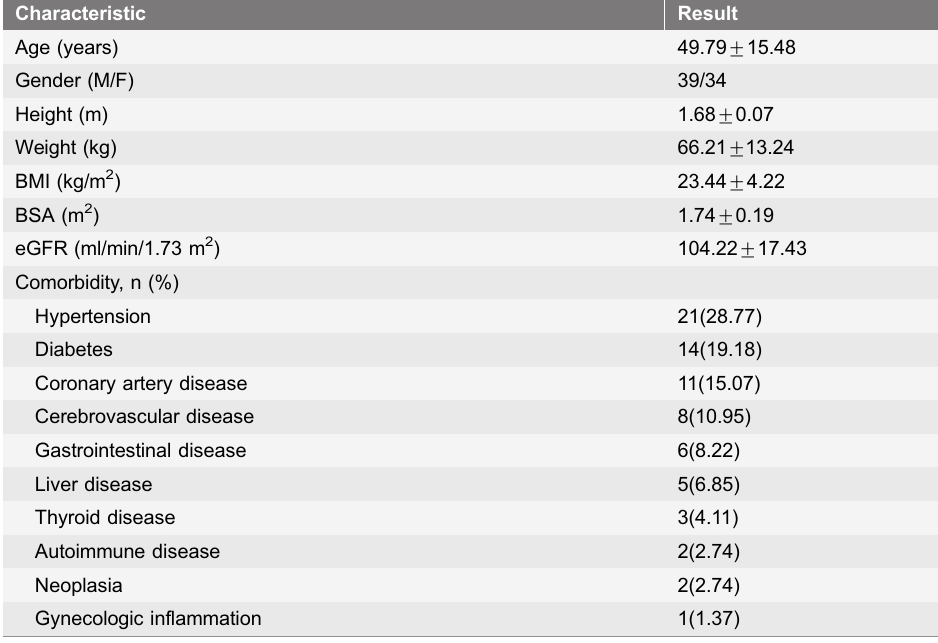
Table1. Patient demographics and anthropometric